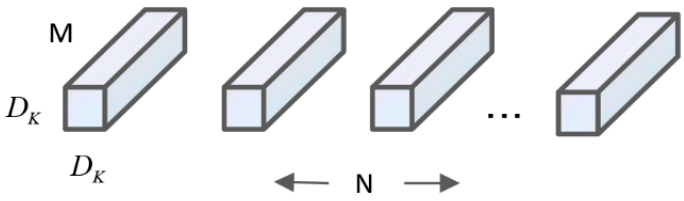
Figure 4. Standard convolution Figure 4. standard convolution structures. Figure 4. standard convolution structures.